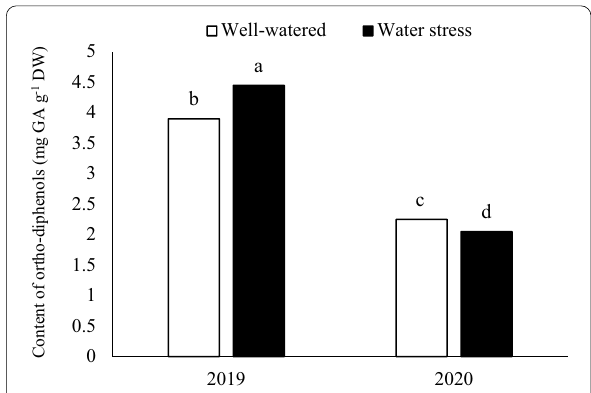
Fig. 5 Two-way interaction of year ortho-diphenols